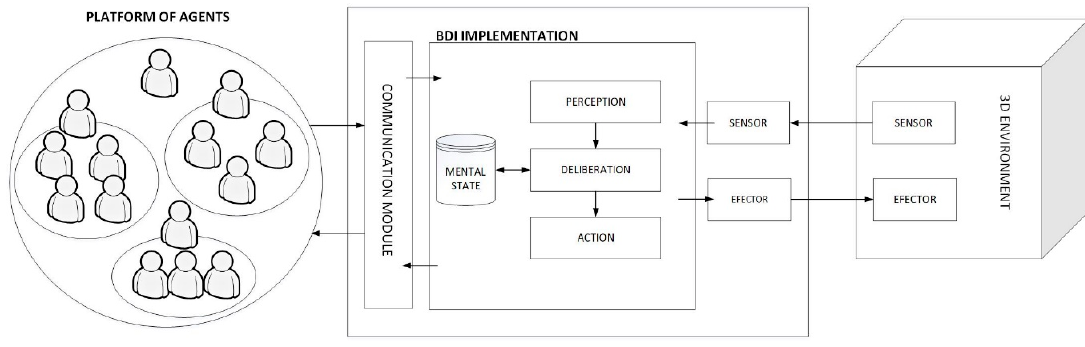
Figure 6. Agent structure.